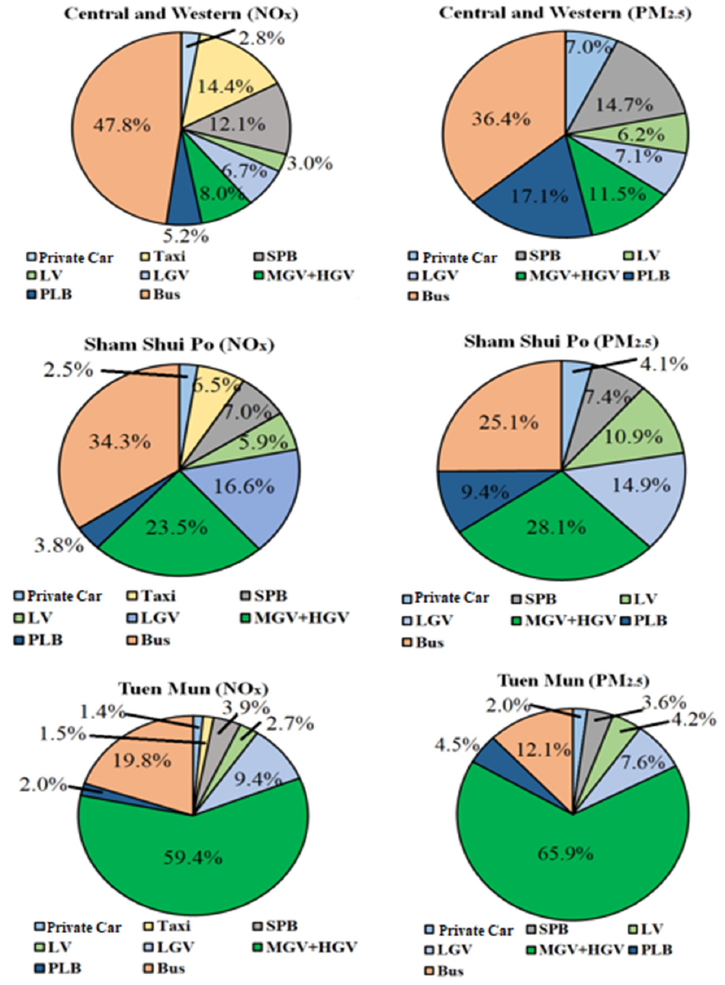
Figure 4. Percentages of NO x and PM 2.5 emissions from different vehicle types in Central and Western (commercial district), Sham Shui Po (industrial district) and Tuen Mun (residential district). SPB: private light buses and non-franchised buses, LV: van-type light goods vehicles weighing less than 3.5 tonnes, LGV: light goods vehicles with two axles, MGV + HGV: medium goods vehicles more than 6 m long, PLB: green and red minibuses